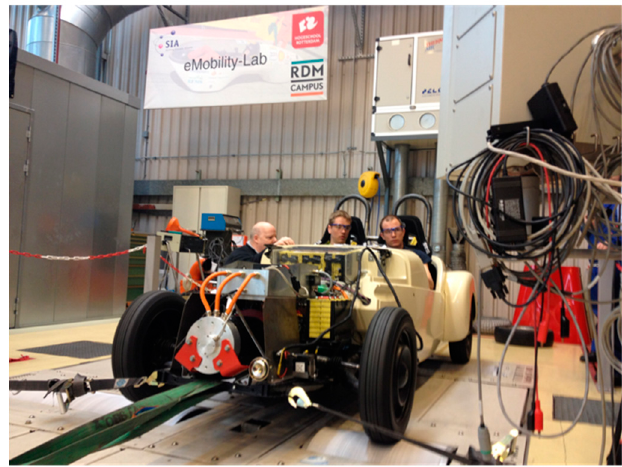
Figure 3. EV testing at the eMobility-Lab at RDM Campus. Reproduced with permission from Rotterdam University of Applied Sciences, The Netherlands.